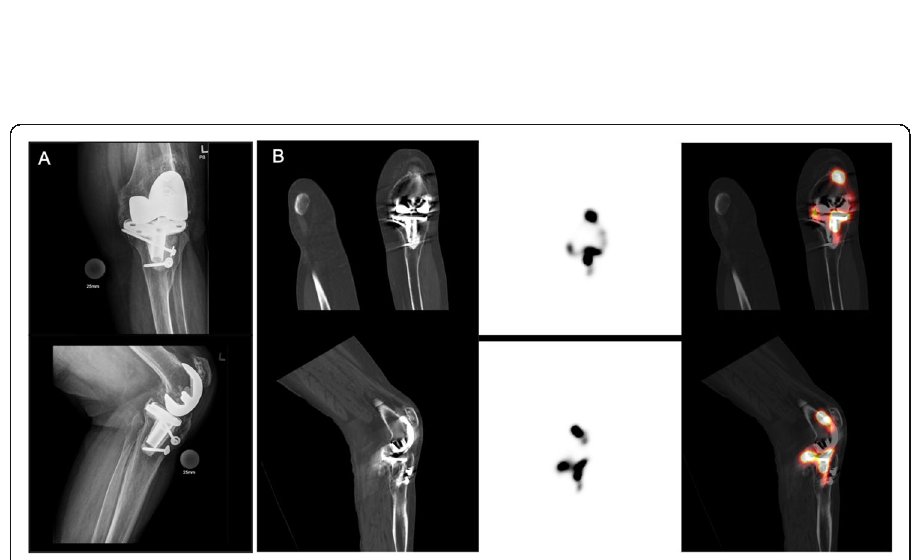
Fig. 3 Tibial component loosening of a left knee total arthroplasty. The radiograph images demonstrate no evidence of loosening (first column). Coronal (top) and sagittal CT (second column), SPECT (third column), and fused SPECT/CT (fourth column) images showing abnormal tracer activity along the bone-prosthetic interface of the tibial